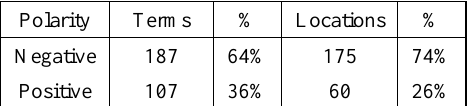
Table 4 . Percentage of negative and positive emotions associated with terms and location.